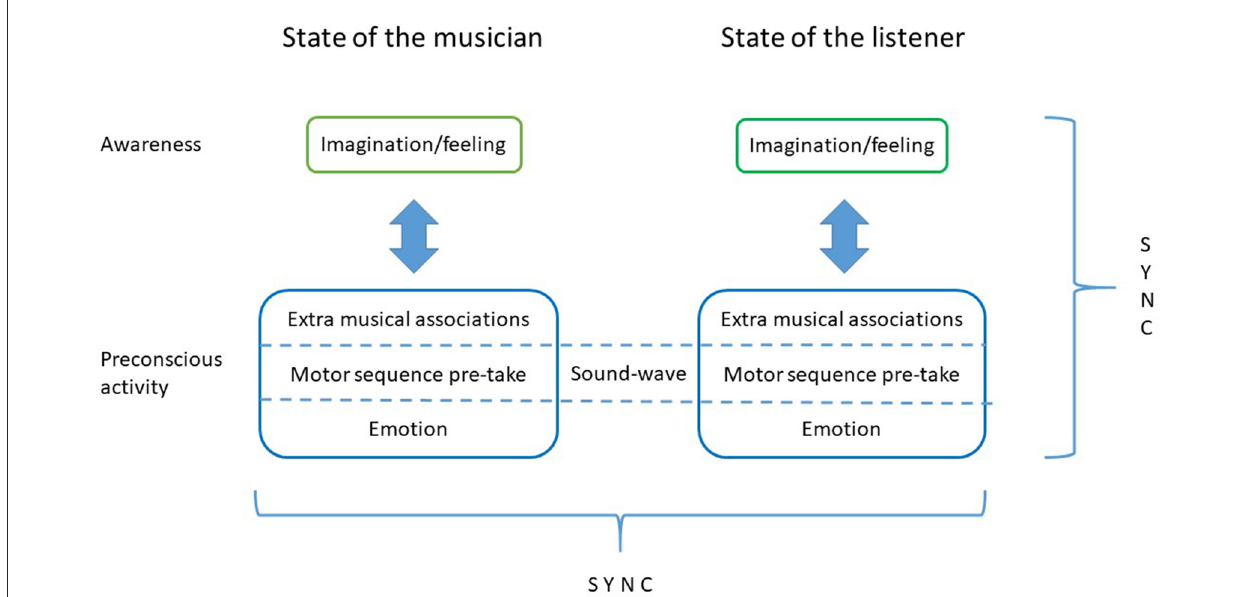
FIGURE3 Musical empathy in an extended cognitive system. The musician and the listener both pre-take the music as it unfolds. It is a mutual enactment. Imagination is awareness of endogenously pre-taken music. The artist performs her neural simulation. The listener endogenously co-performs the work. The artist and the beholder are coupled. The motor sequence is associated with extra-musical memories as well as with emotion.